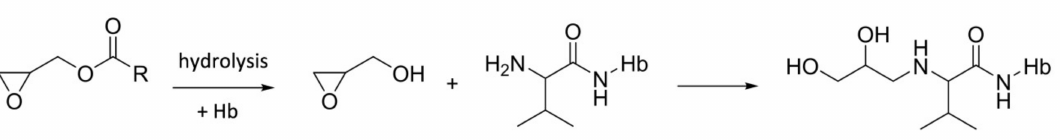
Figure 1. Glycidol is formed in vivo by hydrolysis of glycidyl fatty acid esters [3], where R represents different ester side chains. Glycidol reacts with the N-terminal valine in hemoglobin (Hb) to form N -(2,3-dihydroxypropyl)valine (diHOPrVal) as